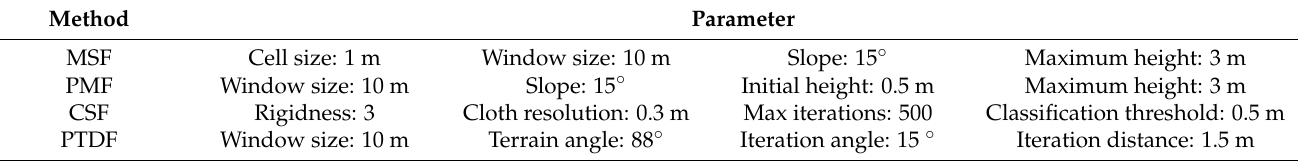
Table 2. Parameter settings of the comparative methods. MSF, PMF, CSF, and PTDF represent the four comparative methods, i.e., maximum slope filtering, progressive morphology filtering, cloth simulation filtering, and progressive triangular irregular network densification filtering